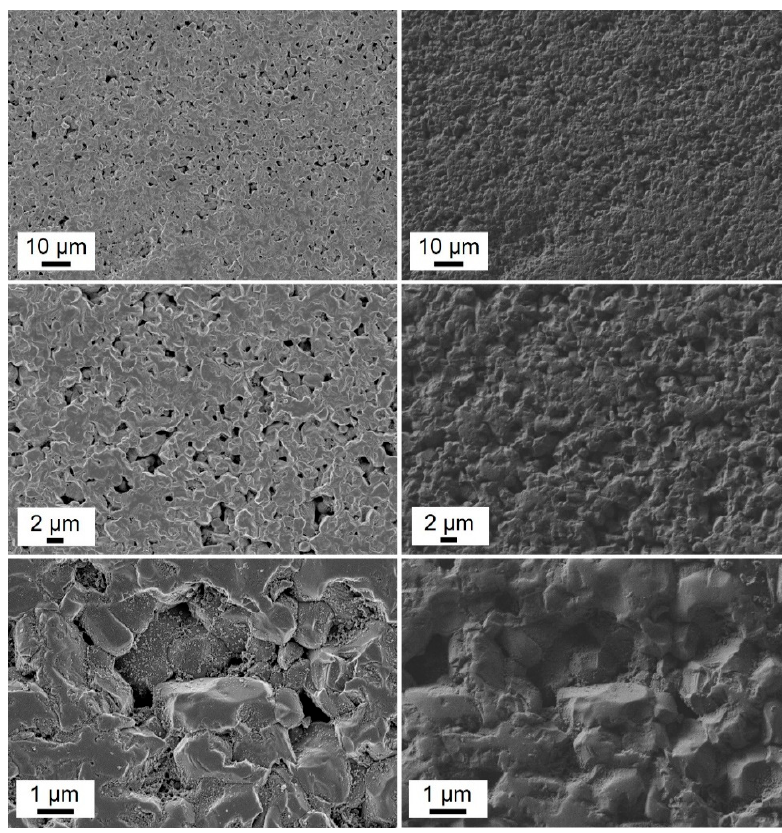
Figure 7. Different magnification of field-emission scanning electron microscopy (FESEM, left ), and corresponding secondary electron detector ( right ) images of ZrB 2 –SiC–TaC.